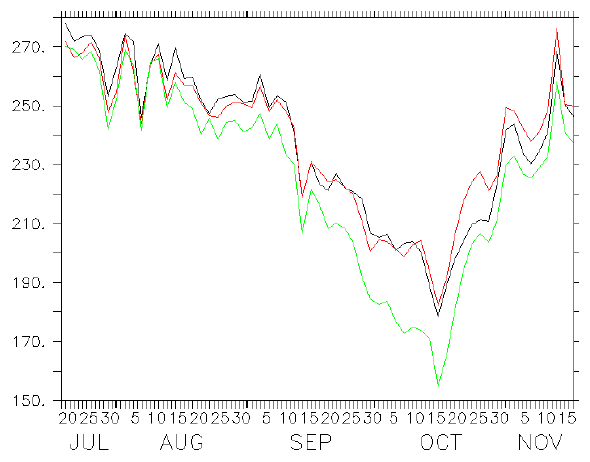
Fig. 5. Minimum total column ozone (DU) for S-E4CHEM (black), S-MECCA(E4CHEM) (red) and S-MECCA(EVAL)